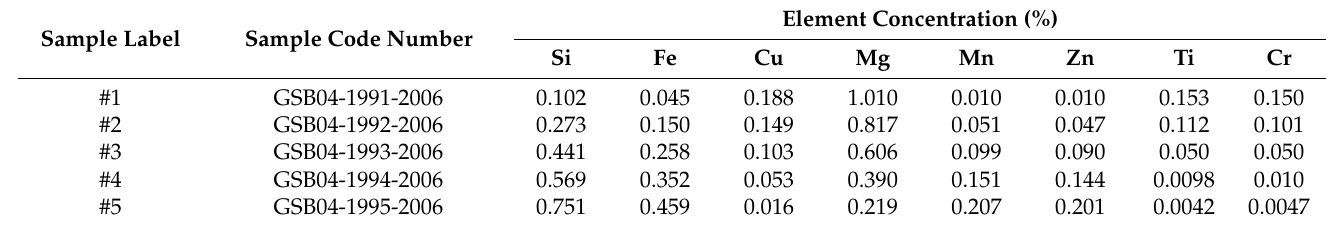
Table 1. The chemical contents in the five standard aluminum alloy samples and their